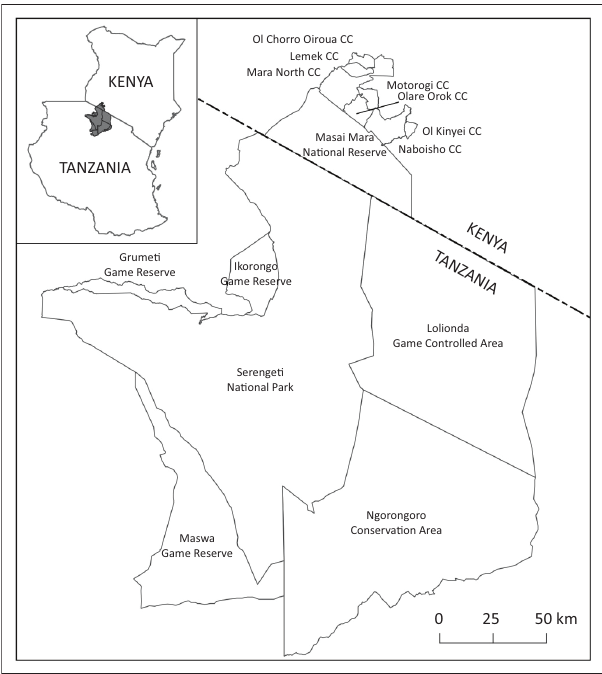
FIGURE 1: Location of the Masai-Mara National Reserve, the Serengeti National Park, and surrounding protected areas in East